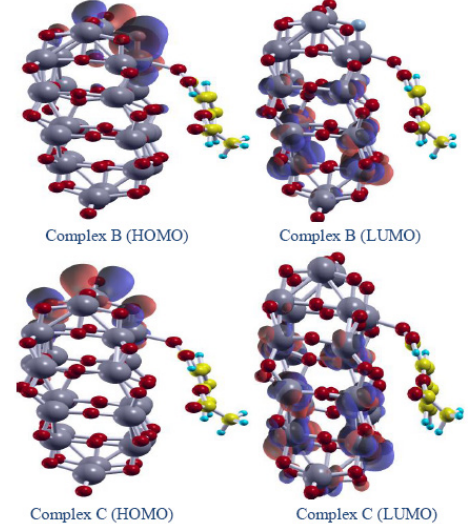
Fig. 10. The isosurfaces of HOMO and LUMO molecular orbitals of the studied systems consisting of the aspirin molecule adsorbed on the TiO2 nanoparticles for parallel configuration. The orange and blue colors represent the positive and negative value areas respectively.